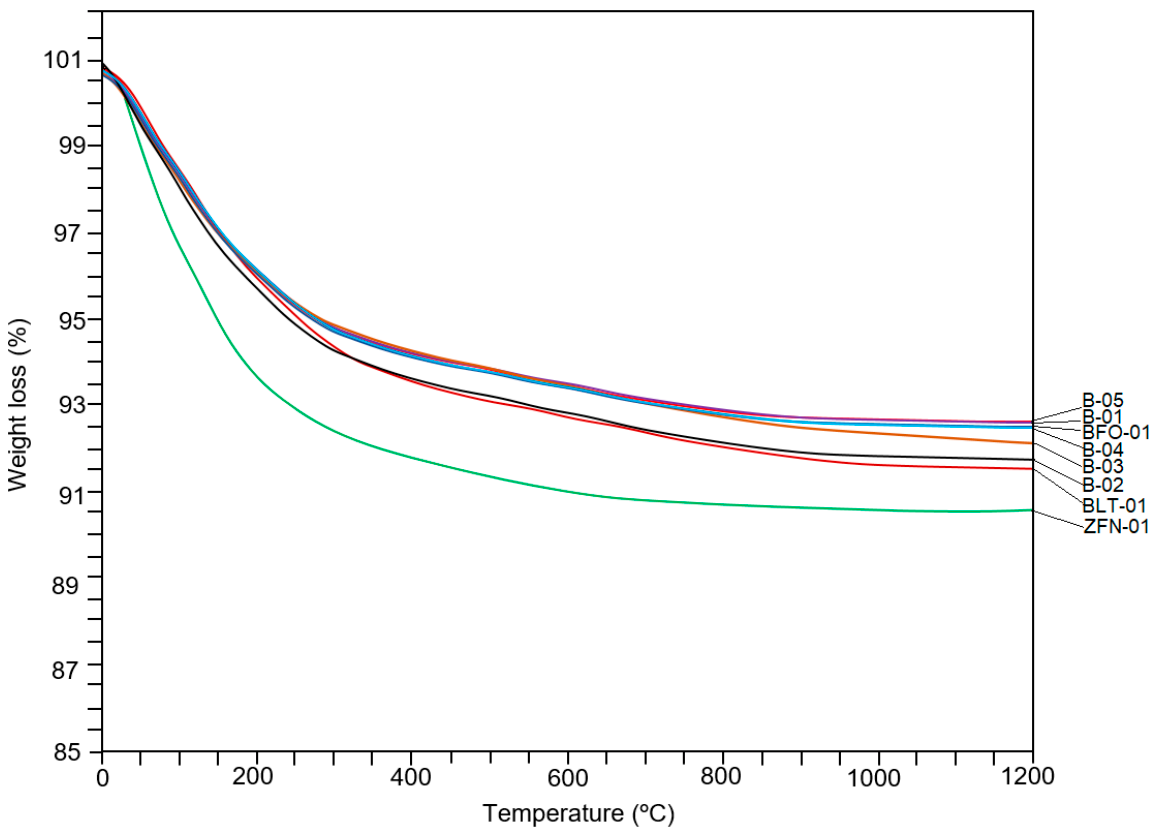
Figure 8. TGA thermograms of bentonites from the research and surrounding areas.